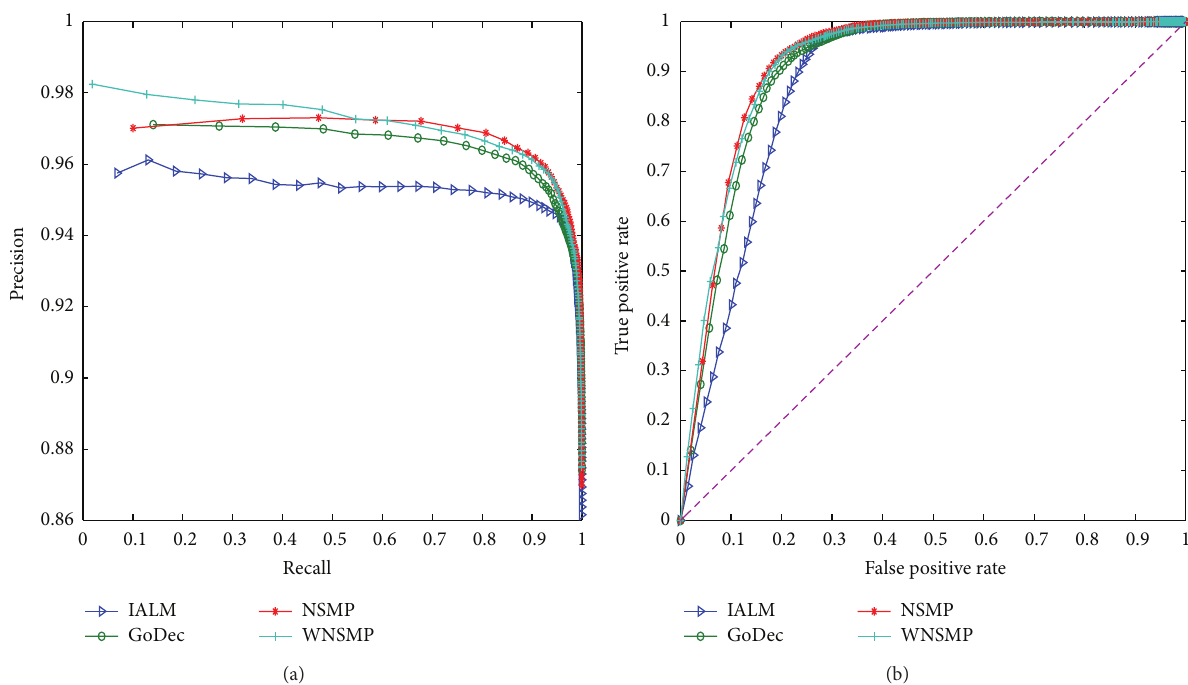
Figure 7: PR curves and ROC curves for the background modeling of IALM, GoDec, NSMP, and